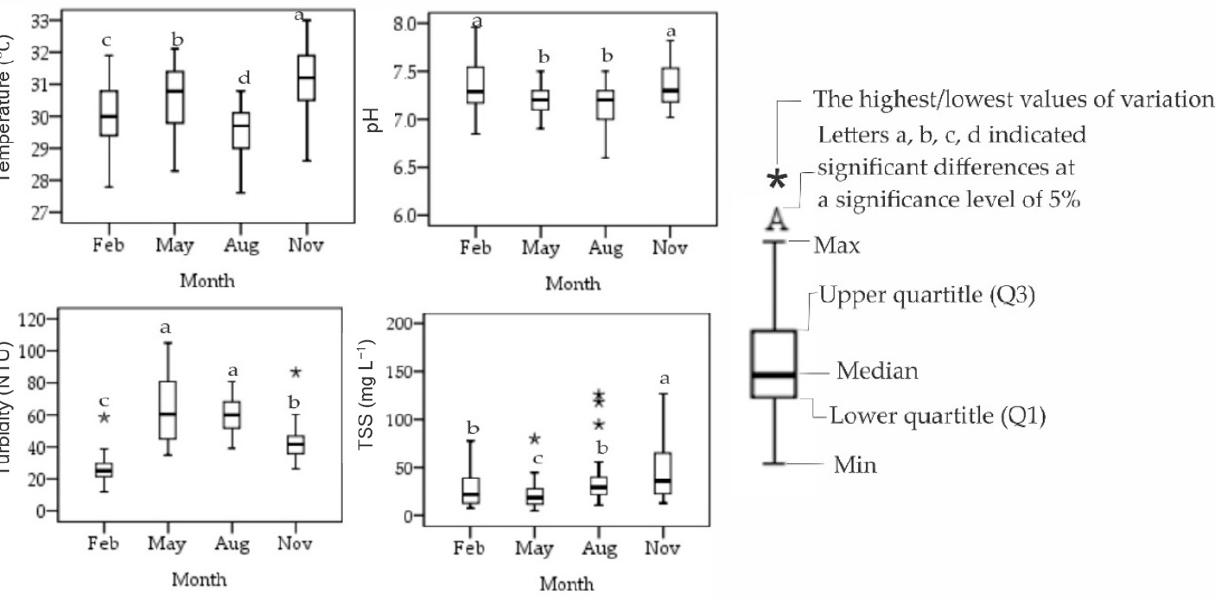
Figure 2. General conditions of water quality parameters in Dong Thap province in 2019.